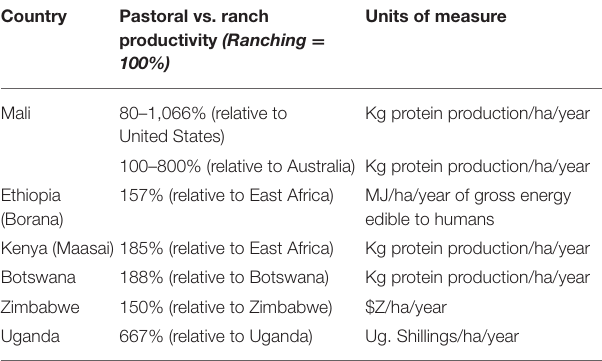
Sources: Mali: Penning de Vries and Djiteye (1982); Ethiopia: Cossins (1985); Kenya: Western (1982); Botswana: De Ridder and Wagenaar (1984); Zimbabwe: Barrett (1992); Uganda: Ocaido et al.